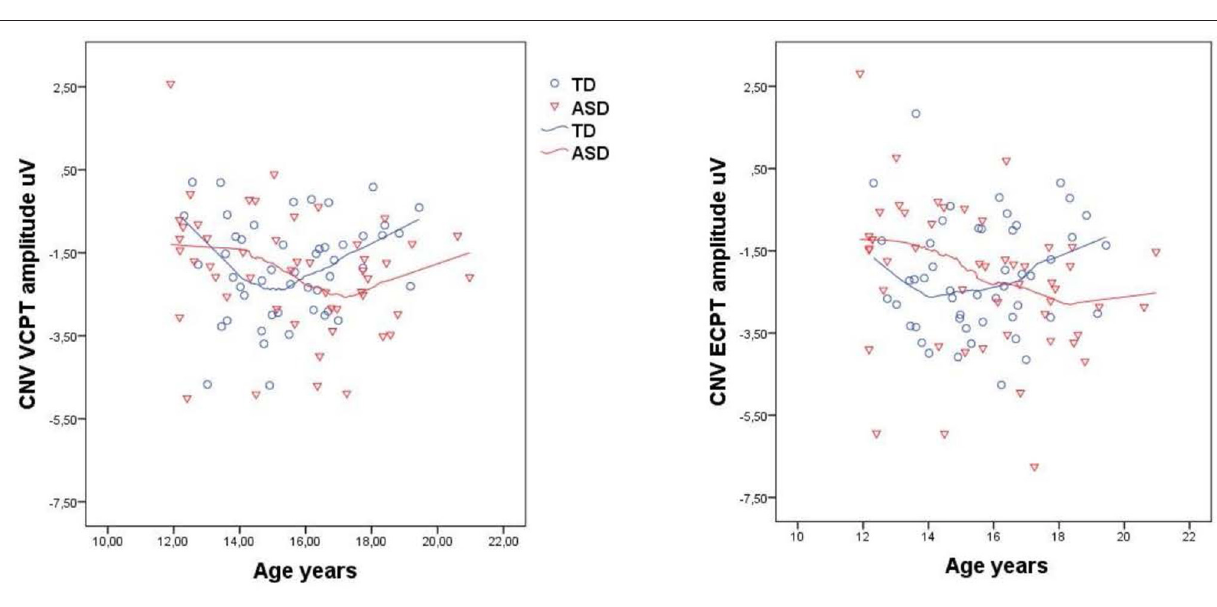
FIGURE 4 | Contingent negative variation, CNV, in VCPT/ECPT vs. age in typical developing adolescents (TD) and adolescents with autism spectrum disorders (ASD). Scatterplots with loess curves fitted to each diagnostic